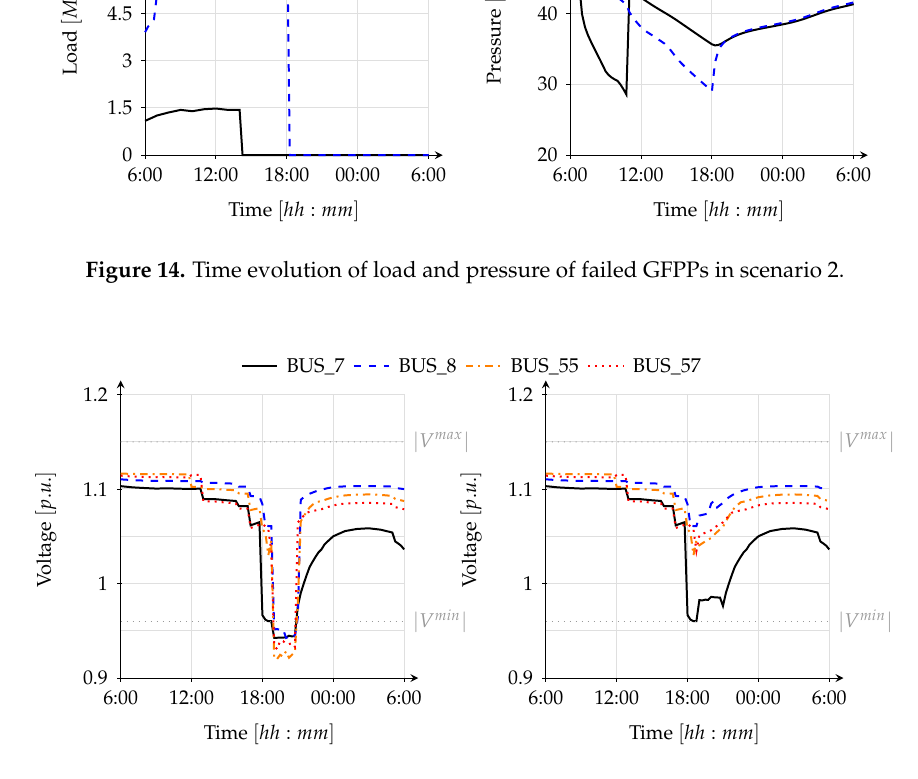
Figure 15. Time evolution of bus voltage before load shedding ( left ) and after ( right ) for scenario 1. All four buses where load shedding was applied are shown in this figure.